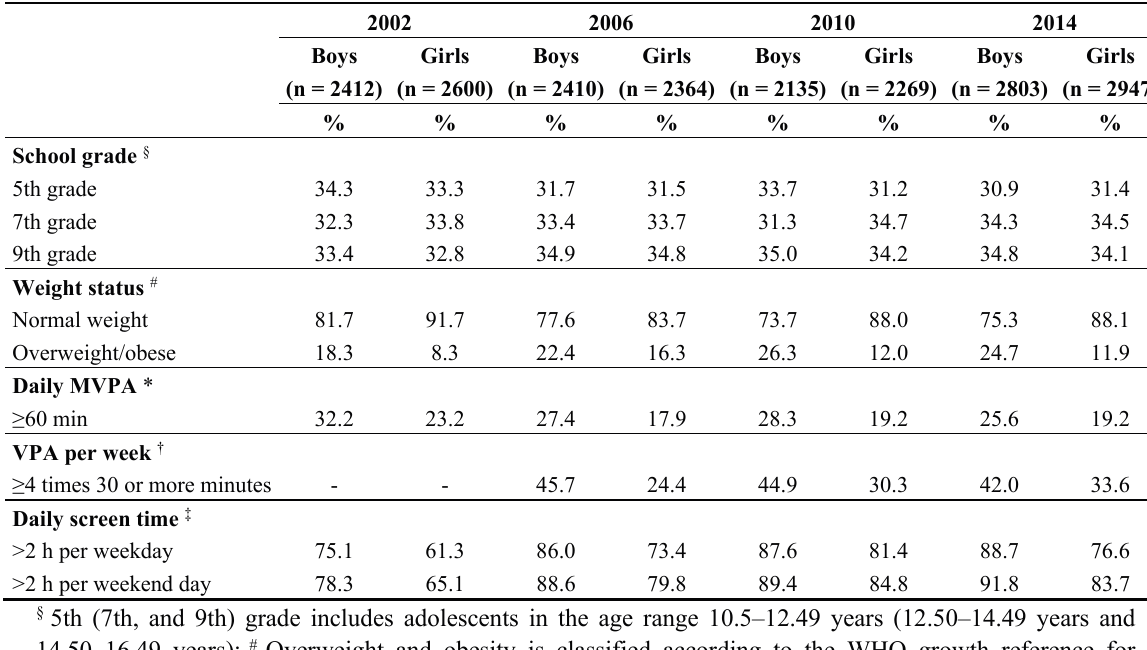
Table 1. Descriptive characteristics of the samples, Health Behaviour in School-aged Children study, Czech Republic